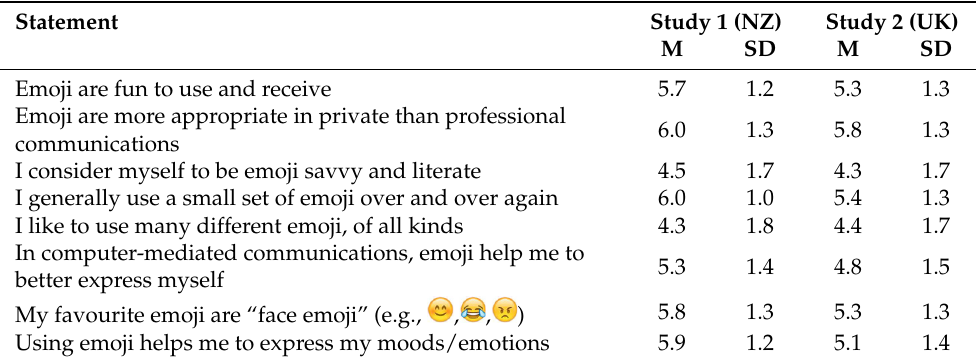
Table 3. Average score * (M) and standard deviation (SD) for general emoji attitudes among partici- pants. Shown for Study 1 (NZ: n = 165 and Study 2 (UK: n =